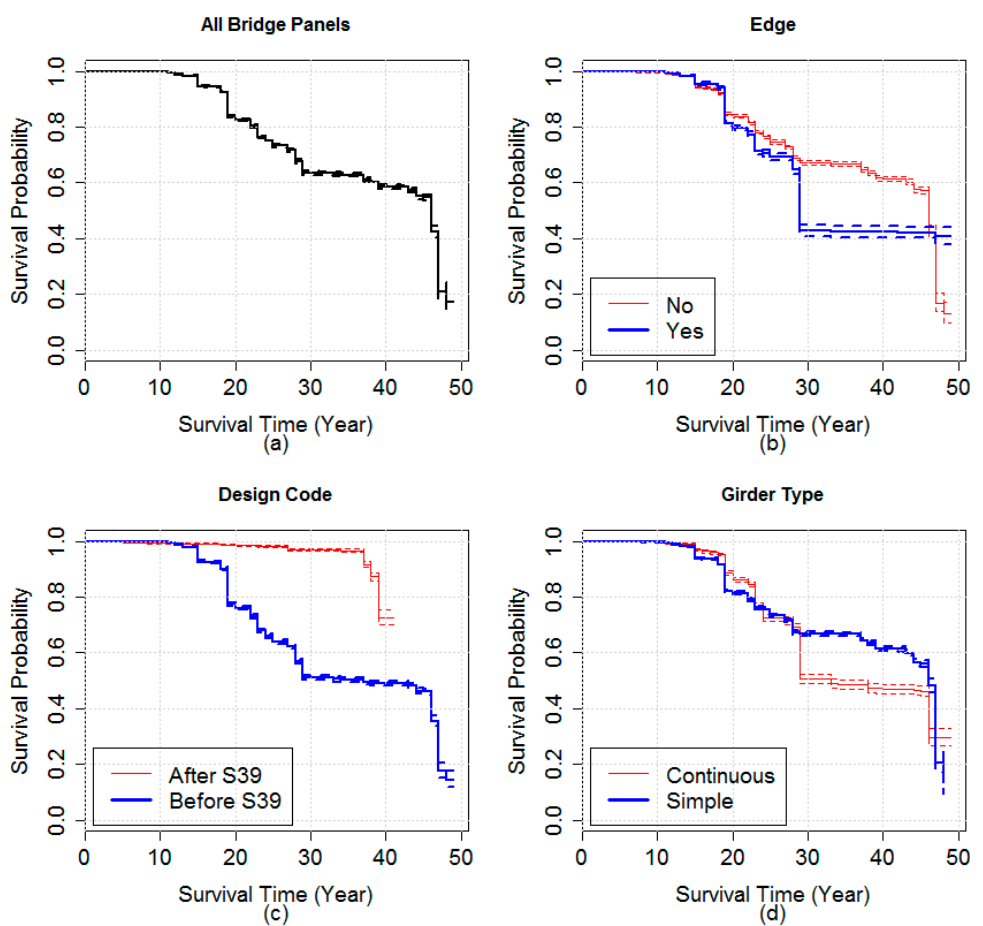
Figure 15. Survival probability of some category variables in Tokyo region; ( a ) all panels; ( b ) edges; ( c ) design code; ( d ) girder type.